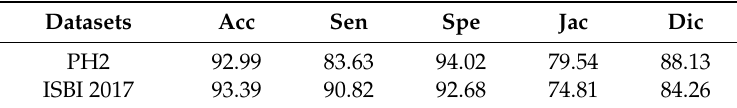
Table 3. Skin lesion segmentation performance (%) of the proposed method on the PH2 and the ISBI 2017.